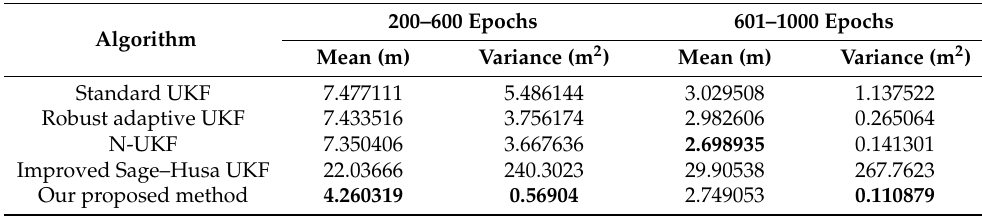
Figure 7. Position tracking errors for Case 3. Table 3. Position tracking errors of the different algorithms for Case 3. The bold numbers stand for the minimum.